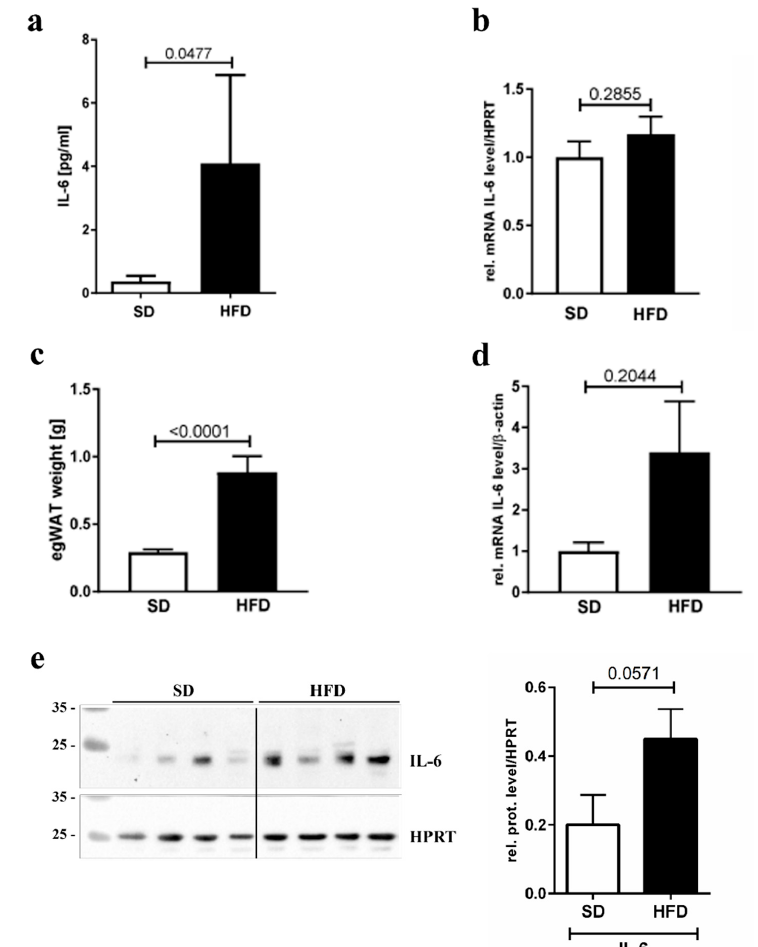
Figure 3. E ff ect of HFD on IL-6 level in blood, placenta, and egWAT. ( a ) IL-6 circulating levels in maternal serum, measured by an ELISA, in SD ( n = 9) and HFD ( n = 10) dams. ( b ) IL-6 mRNA expression level, normalized to HPRT and measured in whole placenta lysates by qPCR. n = 16 placentas from four dams for SD and n = 25 placentas from seven dams for HFD. ( c ) Fat pad weight of epigonadal white adipose tissue (egWAT). n = 12 for SD and 14 for HFD. ( d ) qPCR analysis of IL-6 mRNA levels, normalized to beta-actin, in egWAT. n = 8 for SD and HFD. ( e ) Western blot analysis of IL-6 levels in egWAT lysates. HPRT was detected for normalization. Relative IL-6 / HPRT levels, quantified by densitometry, are indicated in the bar graph next to the western blot. The p -value is indicated in the graph above the bars. n = 4 for SD and